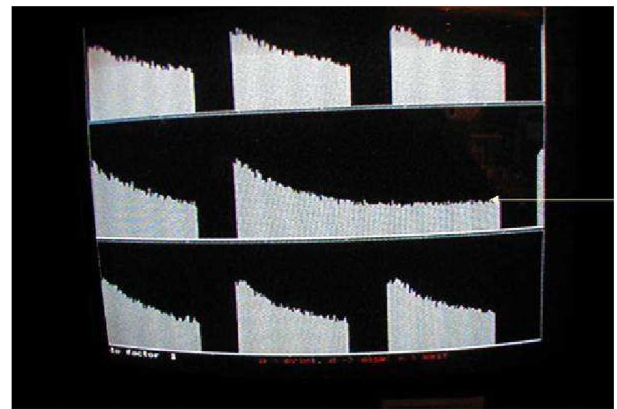
FIG. 17. (Color) Luminosity versus bunch number recorded at the PEP-II B factory in July 2000 for a bunch spacing of four rf buckets with eight additional large gaps [104]; only one straight solenoid was installed at this time. The three traces, when strung together from top to bottom, represent one full turn.